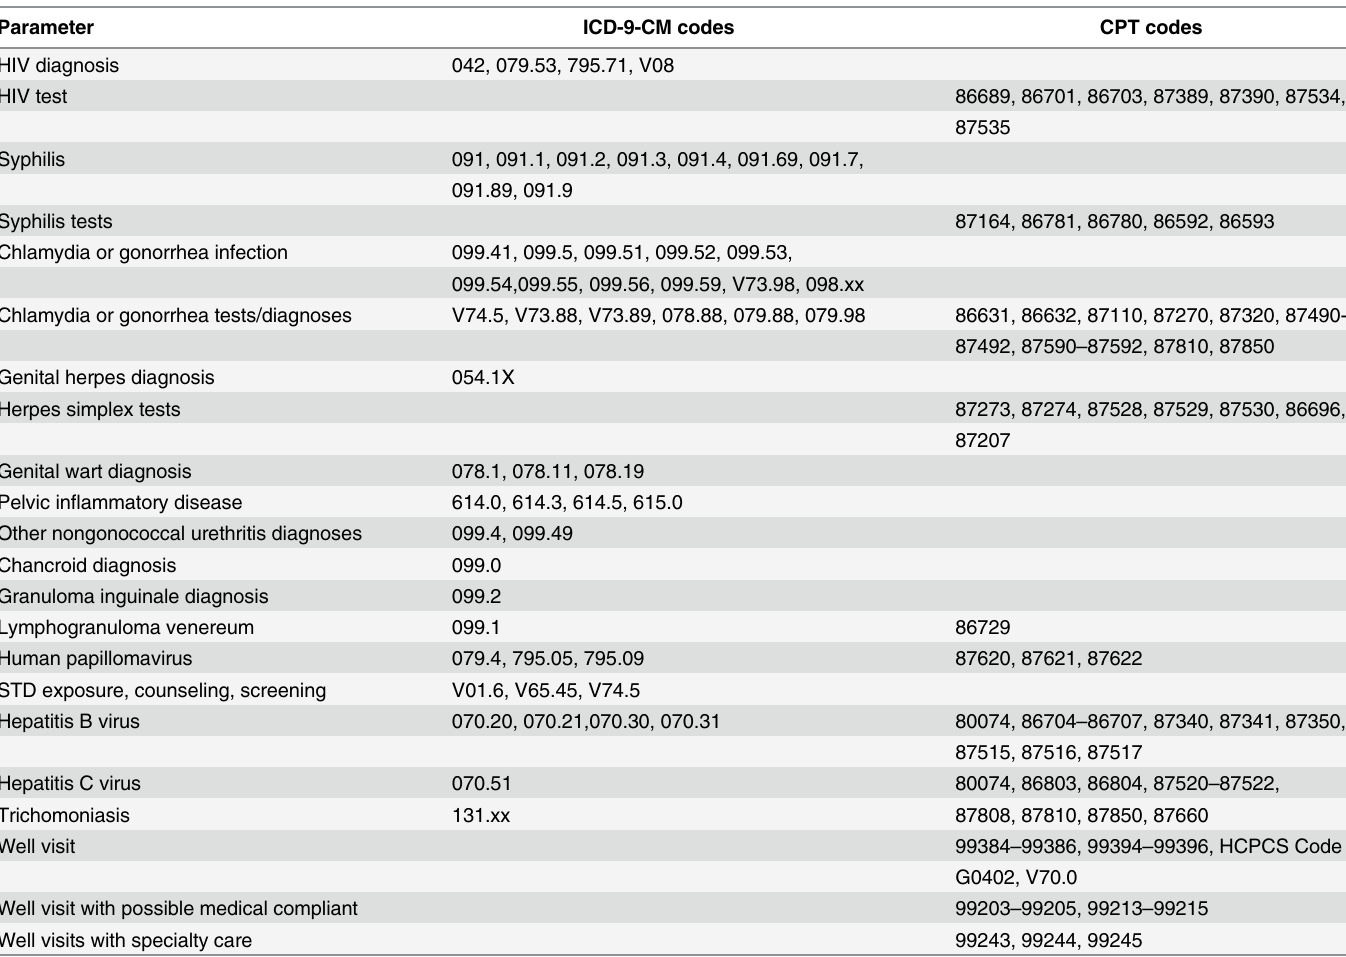
Table 1. International Classification of Diseases, Clinical Modification (ICD-9-CM) codes and Current Procedural Terminology (CPT) codes for tests and diagnoses for HIV, sexually transmitted infections, and Hepatitis B or C virus,